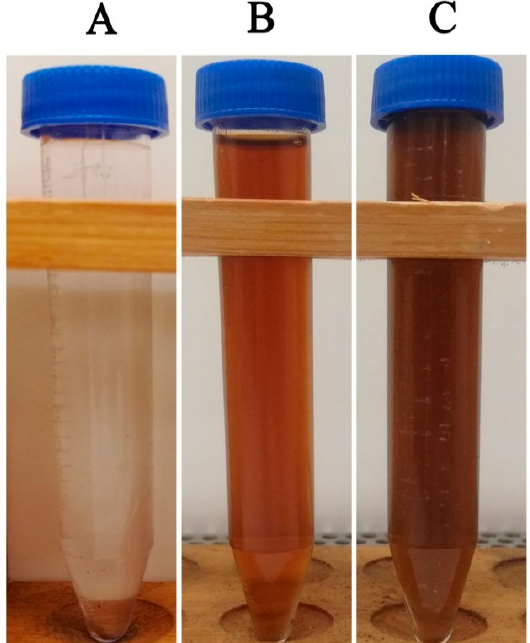
Figure 1. Change in the color of AgNO 3 solution after the addition of S. officinalis extract. ( A ): colorless AgNO 3 solution; ( B ): water extract of Salvia officinalis leaves; ( C ): AgNPs dark brown solution.